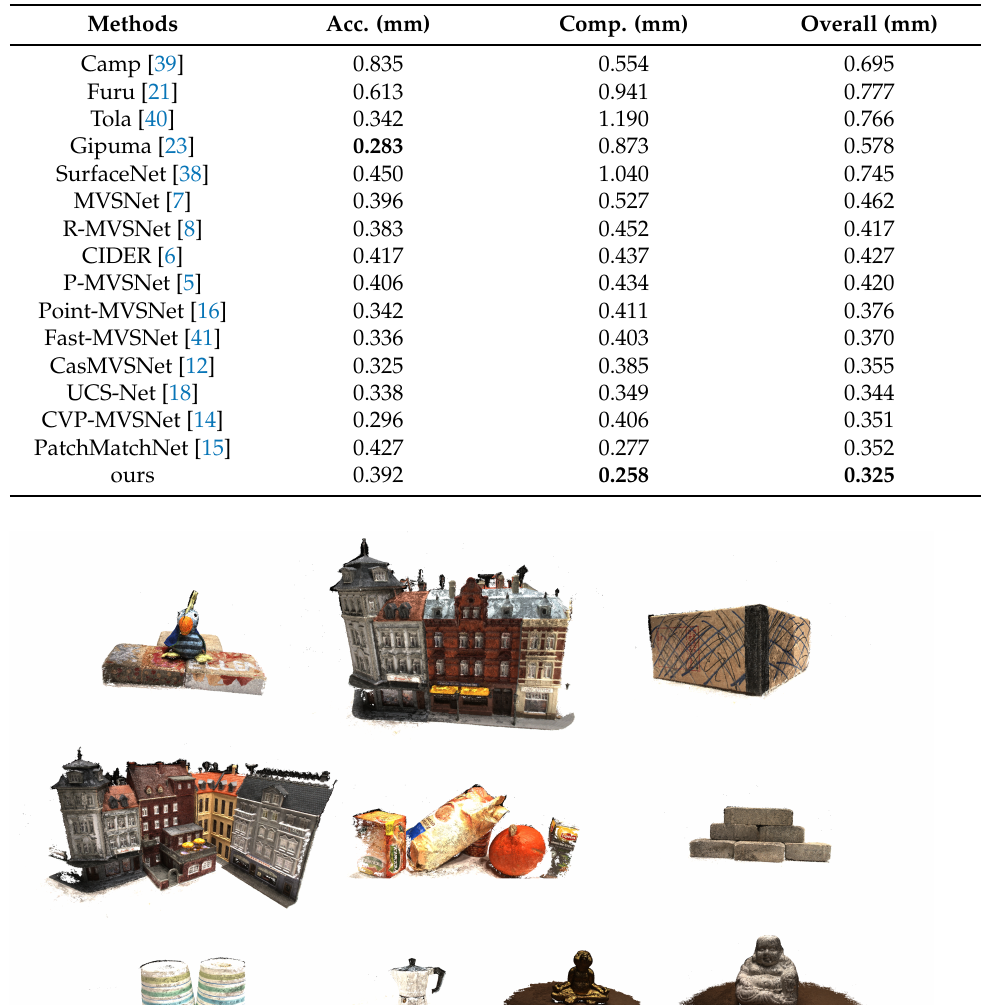
Table 1. Quantitative results of different methods on DTU’s evaluation set [9] (lower is better).